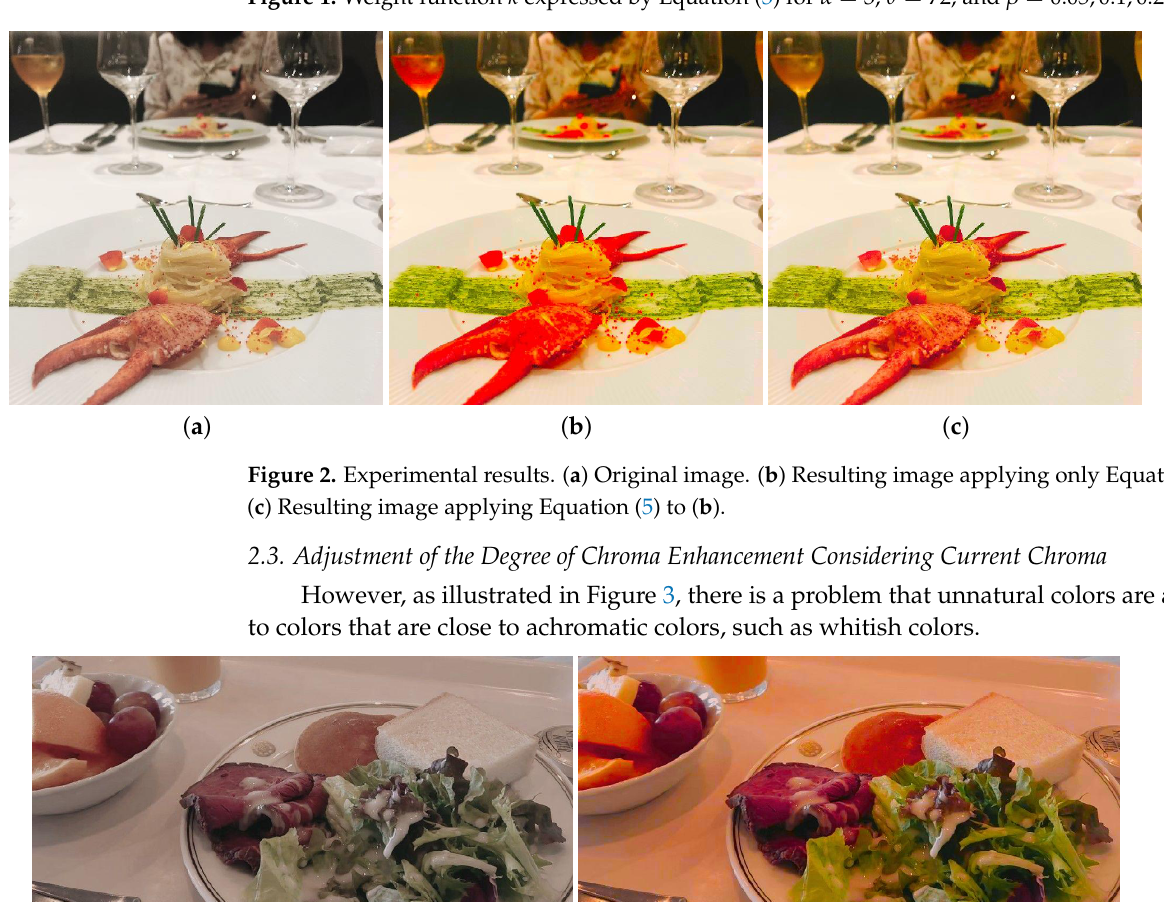
Figure 1. Weight function k expressed by Equation (3) for α = 3, θ = 72, and β = 0.05,0.1,0.2.